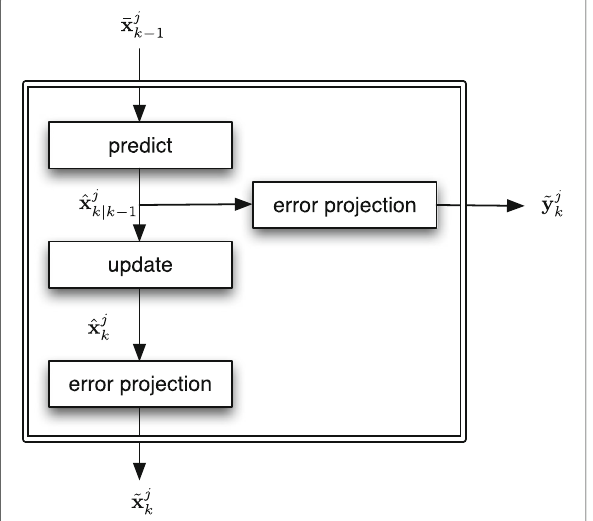
Fig. 2 Modified Kalman filter in constrained IMM algorithm